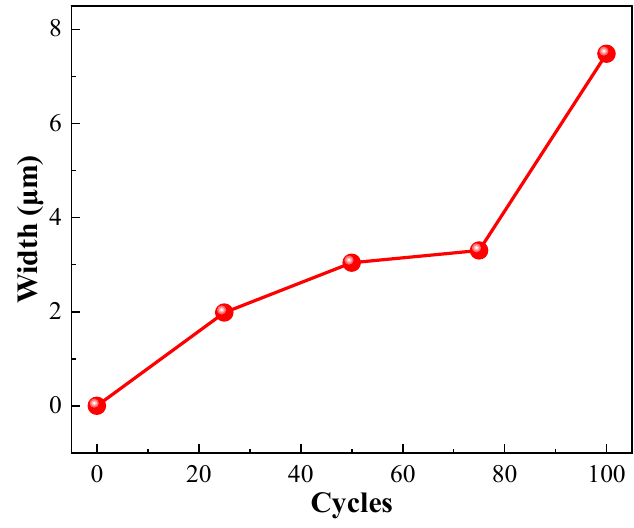
Figure 9. Maximum crack width of the AACGM.